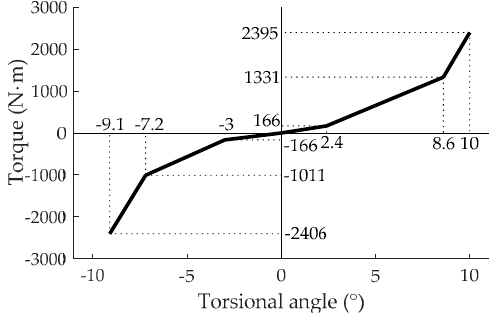
Figure B1. Torsional damper stiffness curve.